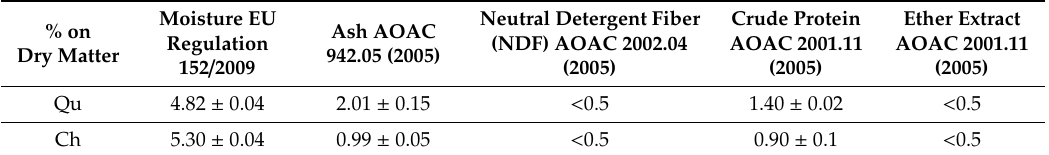
Table 1. Chemical composition of Qu and Ch